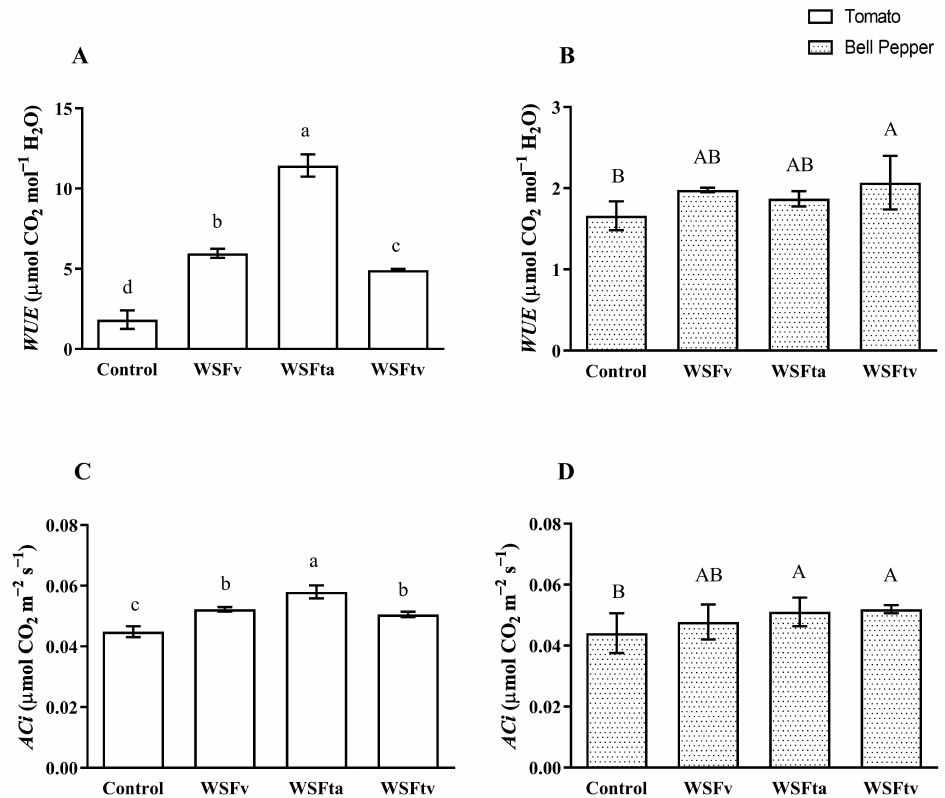
Figure 2. Water use efficiency (WUE) ( A , B ) and carboxylation capacity (ACi) ( C , D ) in Meloidogyne incognita infected tomato and bell pepper plants treated with water-soluble fraction from vermi- compost enriched or not with Trichoderma asperellum and T. virens . Lowercase letters and upper letters represent (LSD, p < 0.05) the effects of treatments for tomato plants and bell peppers plants, respectively. Bars represent means ± standard